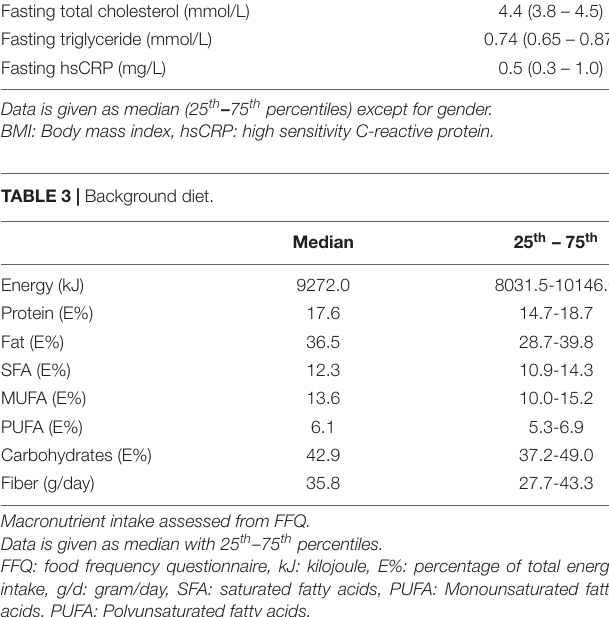
FFQ: food frequency questionnaire, kJ: kilojoule, E%: percentage of total energy intake, g/d: gram/day, SFA: saturated fatty acids, PUFA: Monounsaturated fatty acids, PUFA: Polyunsaturated fatty